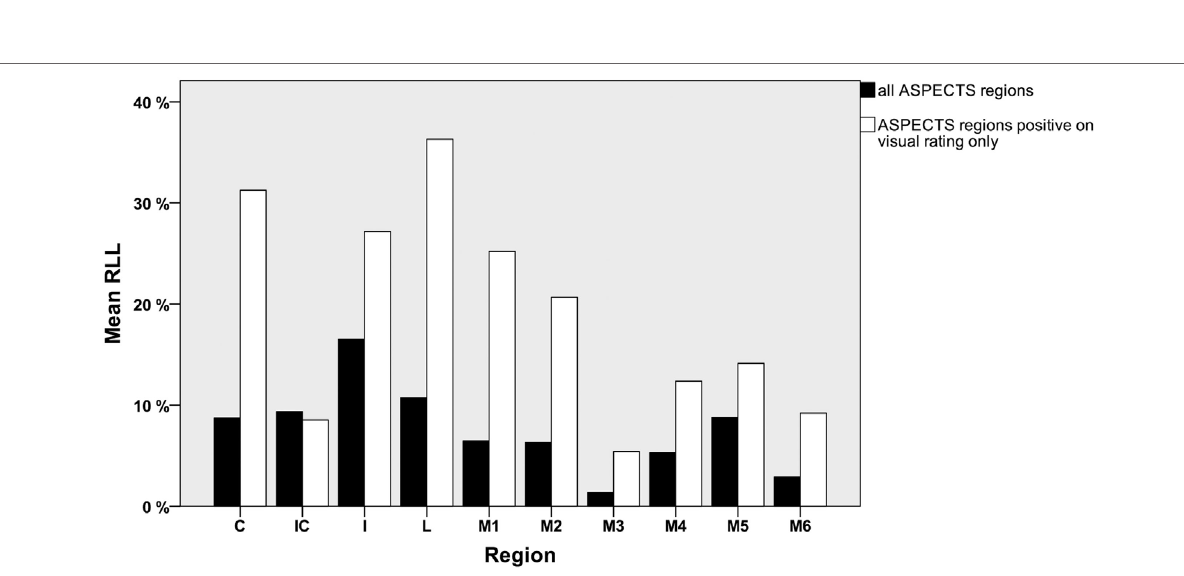
FigUre 2 | Mean relative lesion load (RLL) per ASPECTS region for all patients (black) and mean RLL for visually positive regions only (white).